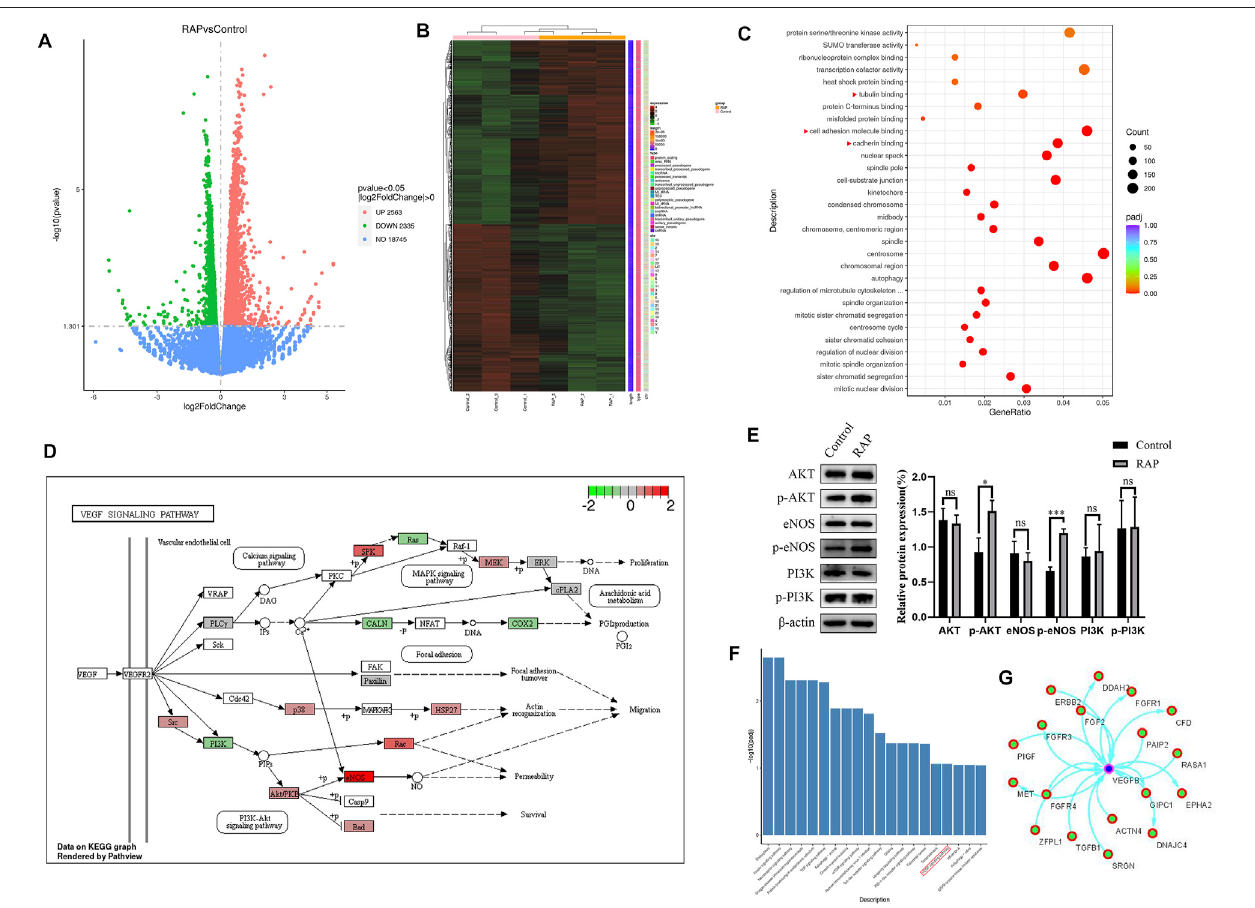
FIGURE 3 | RAP promoted angiogenesis by activating the AKT/eNOS signaling pathway in vitro (A) The volcano plot of DEGs; (B) The heat map of DEGs; (C) The GO function analysis, the red triangle indicates the enrichment associated with angiogenesis; (D) DEGs are enriched in the VEGF signaling pathway (www.kegg.jp); (E) RepresentativewesternblottingandstatisticalanalysisofAKT,p-AKT,eNOS,p-eNOS,PI3K,p-PI3K; (F) TheKEGGpathwayanalysis,theredboxrepresentstheVEGF signaling pathway; (G) The PPI network analysis of proteins encoded by DEGs and VEGFB. Data are presented as means ± SD. * p < 0.05, *** p < 0.001.